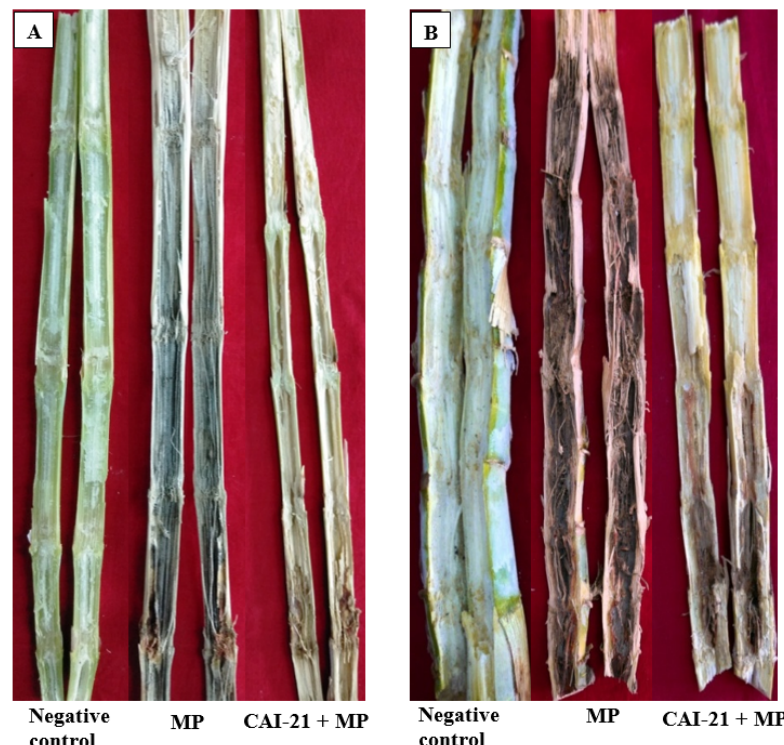
Figure 4. Biocontrol potential of S. albus CAI-21 against charcoal rot of sorghum under greenhouse ( A ) and field ( B ) conditions. MP, M. phaseolina.